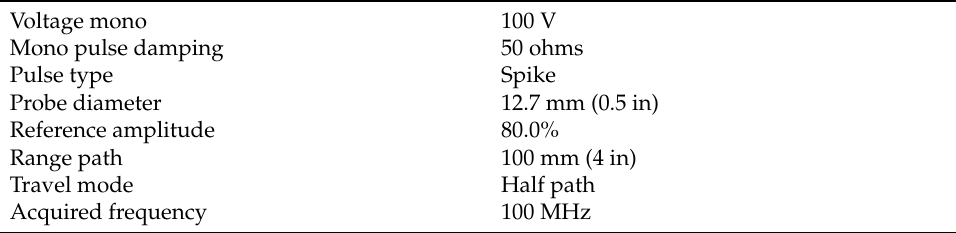
Table 4. Settings used for wave velocity calibration with pulse-echo UT.